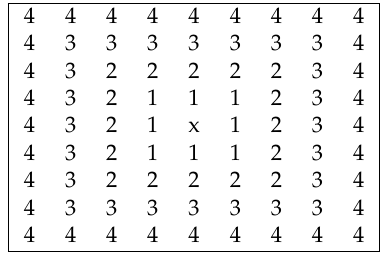
Figure 4. Visualization of the RMSE (1st row) and MAE (2nd row) of the disparity maps computed between the central SAI and each of the remaining 80 SAIs in the LF image, each pixel representing the error for one stereo pair.